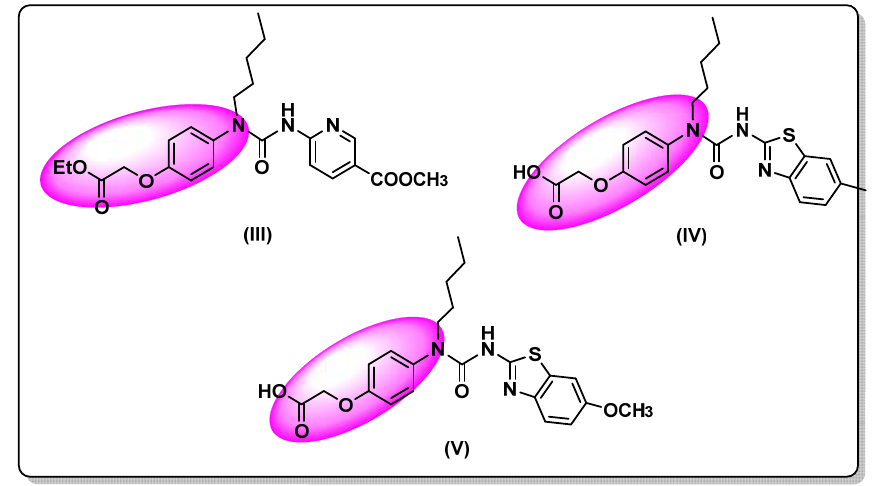
Figure 2. Reported dual activators of GK and PPAR.